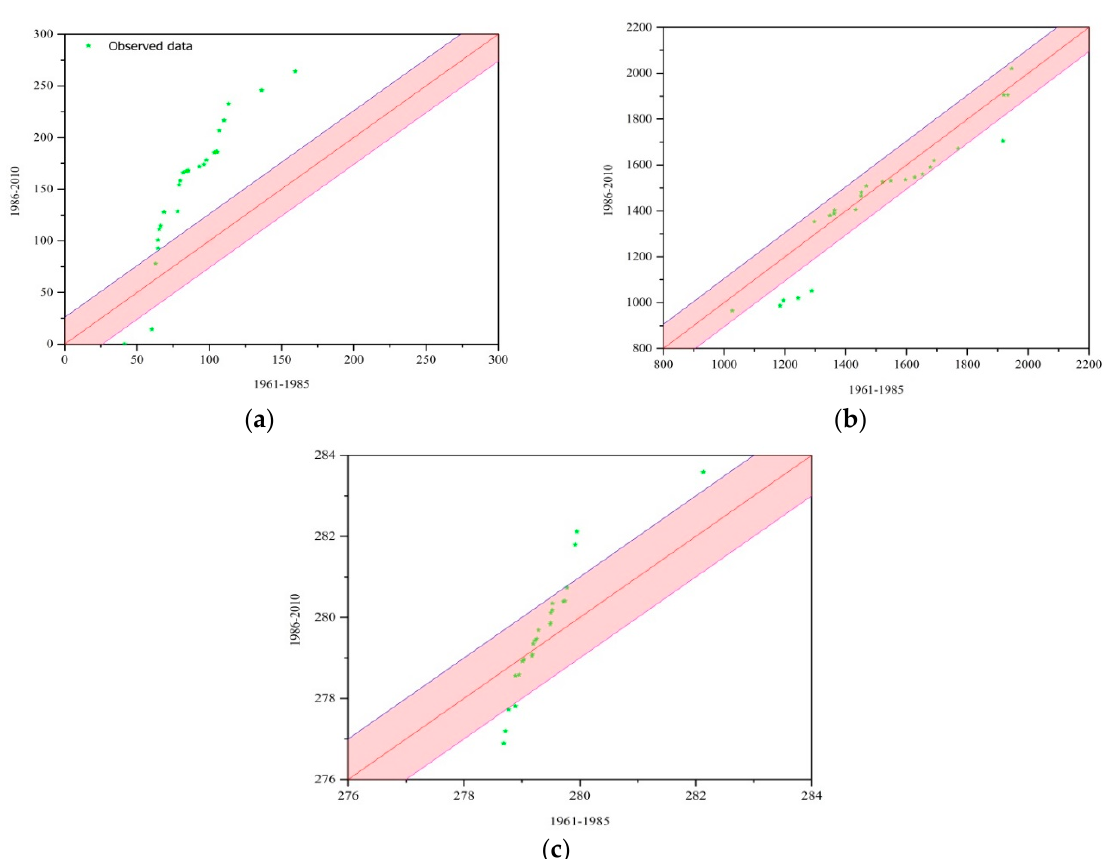
Figure 9. Annual ITA of Precipitation, runoff and temperature Zone I. ( a ) Precipitation ( b ) runoff ( c ). temperature. ( c ).